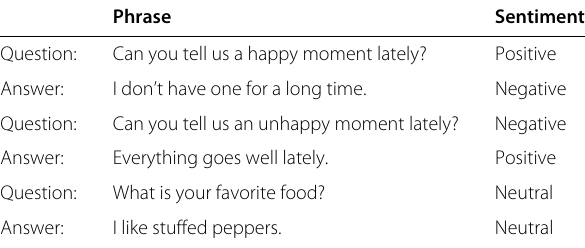
Table 1 Example of an interview in the Turkish database. Sentiment tags of both questions and answers are shown